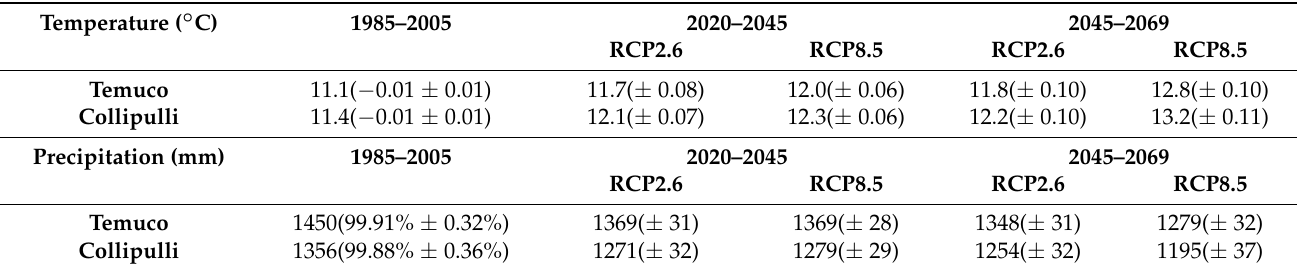
Table 1. Data regarding the average annual precipitation and temperature for the three climatic periods for the two locations (i.e., Temuco and